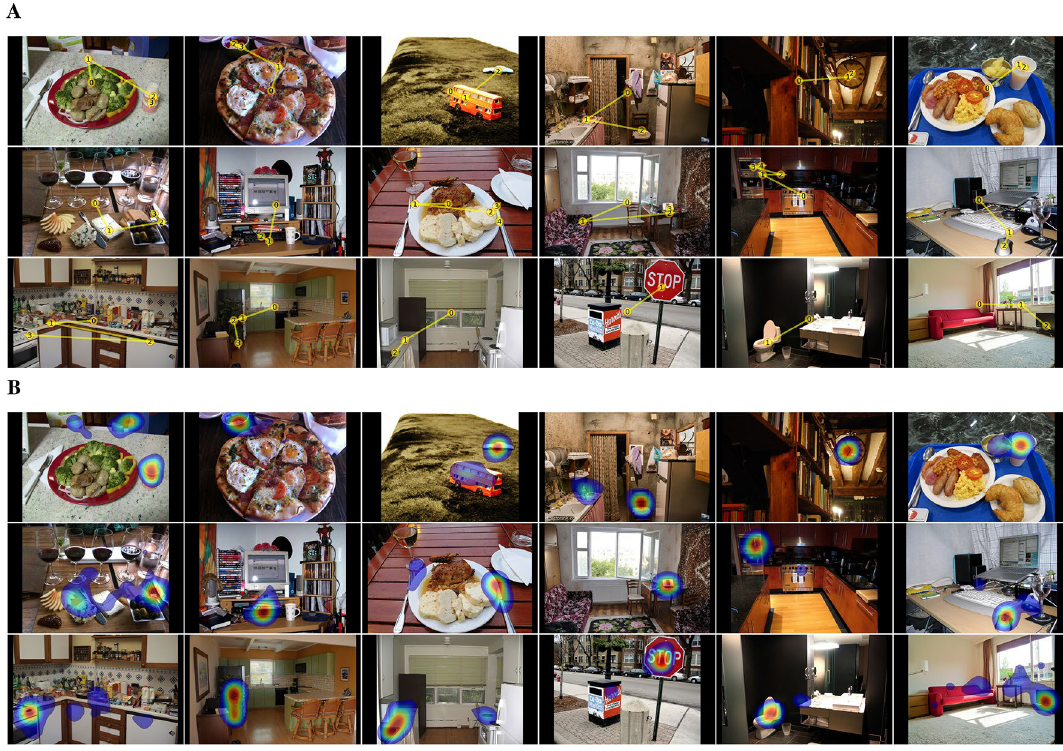
Figure 1. ( A ) Examples of target-present images for each of the 18 target categories. Yellow lines and numbered discs indicate a representative search scanpath from a single participant. From left to right, top to bottom: bottle, bowl, car, chair, (analog) clock, cup, fork, keyboard, knife, laptop, microwave, mouse, oven, potted plant, sink, stop sign, toilet, tv. ( B ) Examples of fixation density maps (excluding initial fixations at the center) computed over participants for the same scenes.